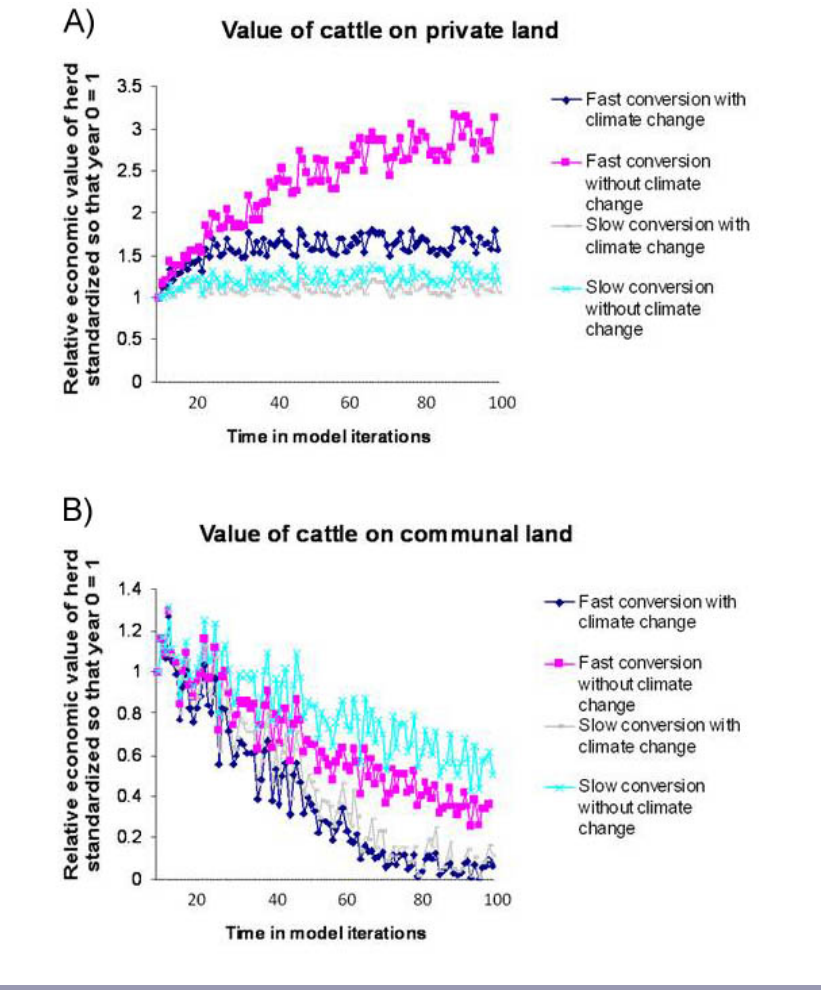
Fig. 7 . Policy scenario options and their impacts on the value of cattle on A) private land and B) communal land across Southern Botswana (as per scenario assumptions in Table